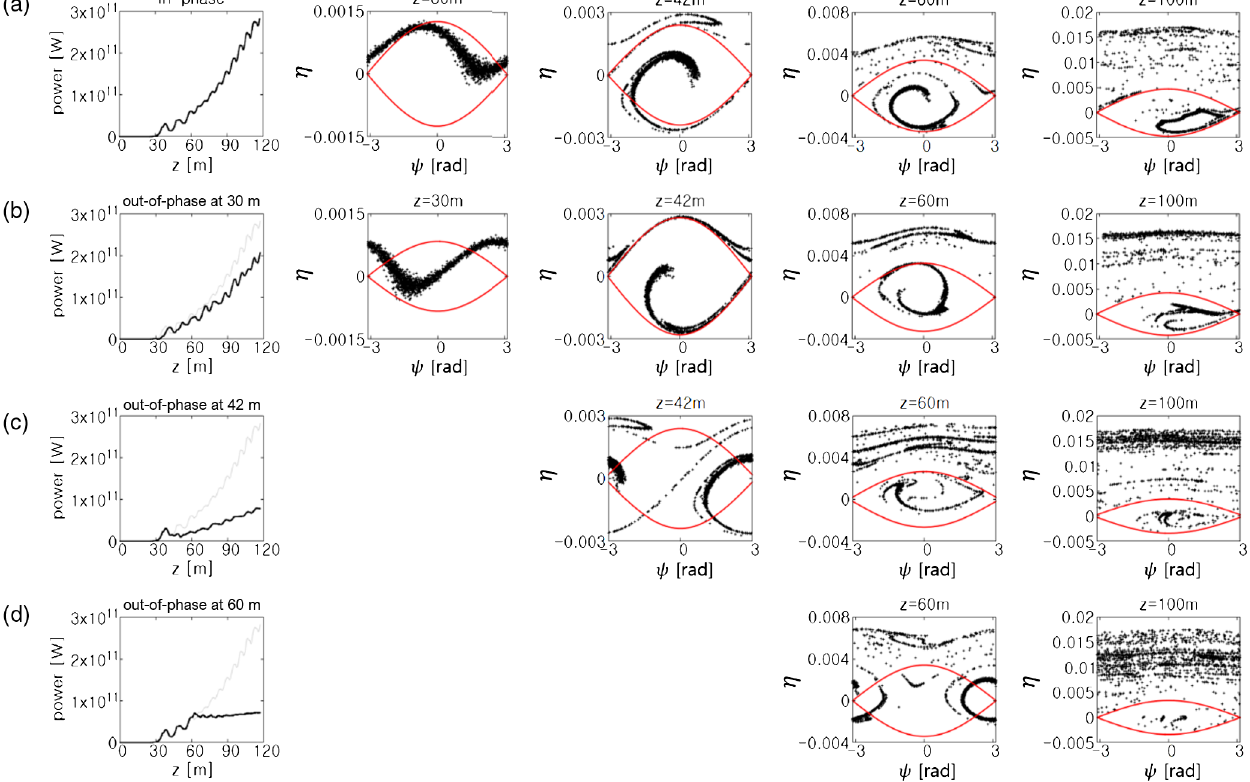
FIG. 2. Comparisons of FEL gain curves with the electron phase distribution from 1D steady state FEL simulation. (a) The in-phase case as the reference. The out-of-phase cases with the phase shifter at (b) 30, (c) 42, and (d) 60 m. Areas between red lines are the phase bucket [Eq.